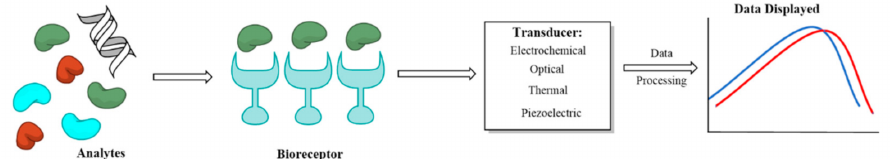
Figure 1. General schematic of a biosensor. Different possible bioreceptors and transducers have been shown. Adapted from Sawant et al. [14] with permission from